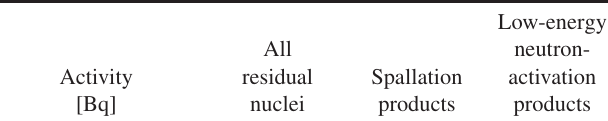
TABLE I. Activity induced by protons and 238 U ions at 1 GeV = u and 200 MeV = u in different targets. The beam loss is 1 W = m in the case of the beam pipe and 1 W in the case of the bulky target. The activity is calculated at the end of irradiation. Numbers in italic represent relative standard uncertainties.